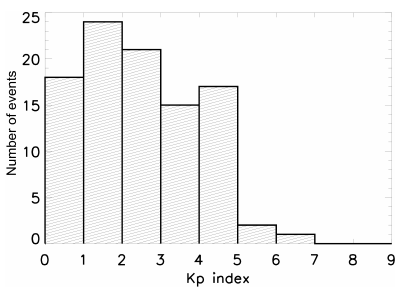
Figure 8. Distribution of the gravity waves according to the geo- magnetic activity as indicated by the Kp index during the time of observation of the gravity